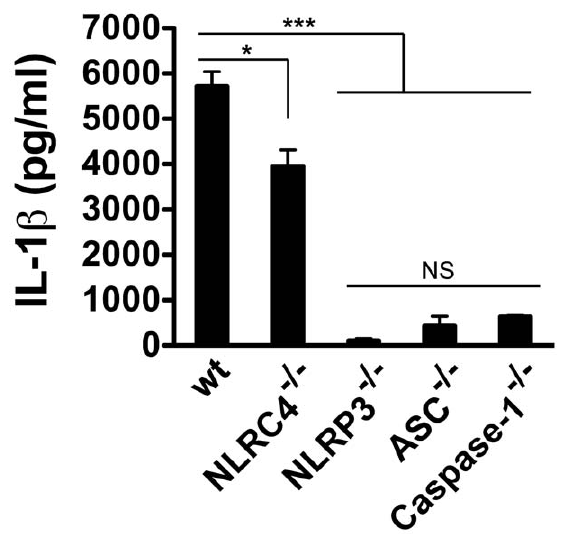
Figure 2. IL-1 b secretion by macrophages infected with B. cenocepacia requires the NLRP3/ASC inflammasome. Bone marrow derived macrophages from wild type (wt), NLRC4 2 / 2 , NLRP3 2 / 2 , ASC 2 / 2 and Caspase-1 2 / 2 (all from C57BL/6 background) were infected with B. cenocepacia MH1K for 1 h at an MOI of 50 and then treated with gentamicin to eliminate extracellular bacteria. ELISA was used to quantify IL-1 b in cell supernatants at 24 h post-infection. *, p # 0.05; ***; p # 0.001; NS, non